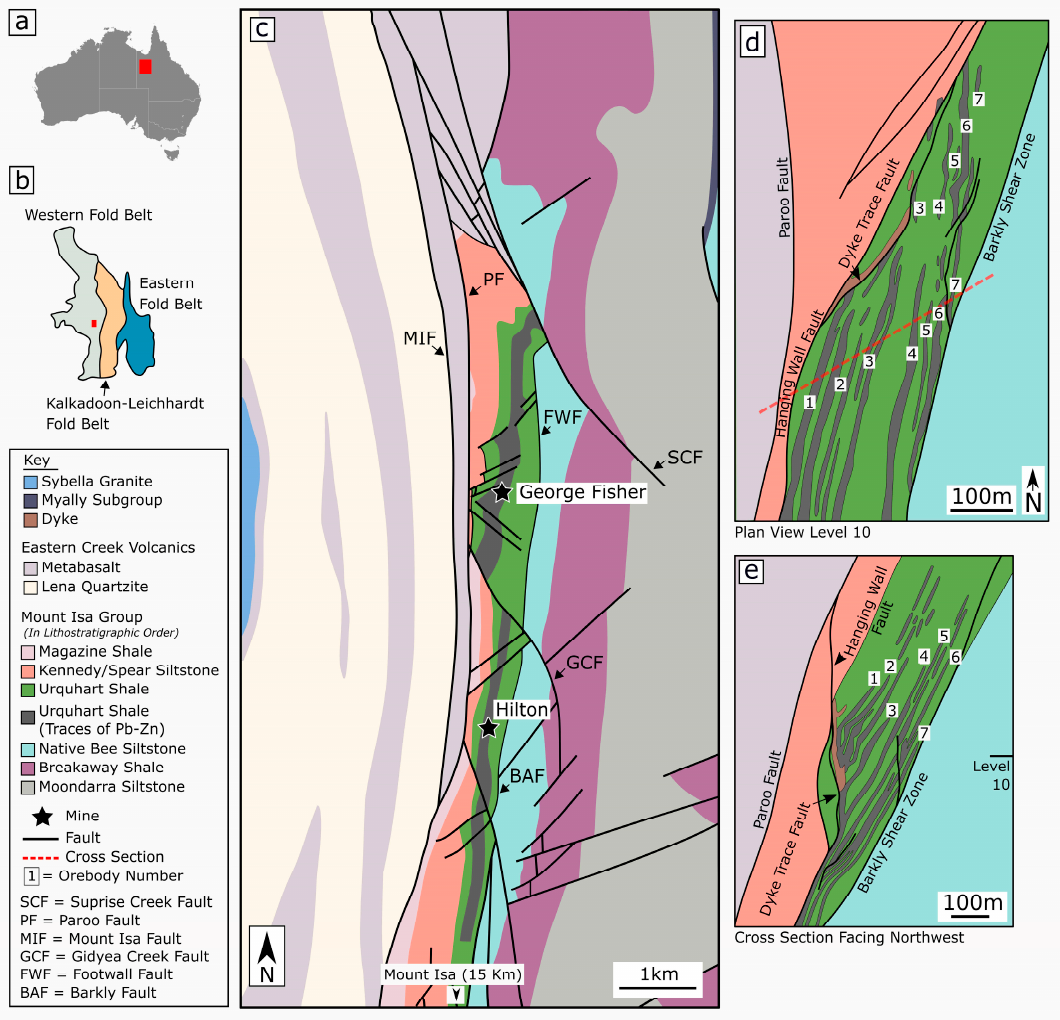
Figure 1. Location of the study area with reference to ( a ) Australia and ( b ) the Mount Isa Inlier. ( c ) A simplified geological map of the study area after Valenta [30] with the location of the Hilton and George Fisher Zn-Pb (Ag) deposits. ( d ) Plan view of the Hilton Zn-Pb (Ag) deposit showing the seven north to south trending stratabound ore zones. ( e ) A schematic cross-section of the Hilton Zn-Pb (Ag) deposit facing northwest. Figure 1d,e have been updated from Valenta [31] using available mine models.